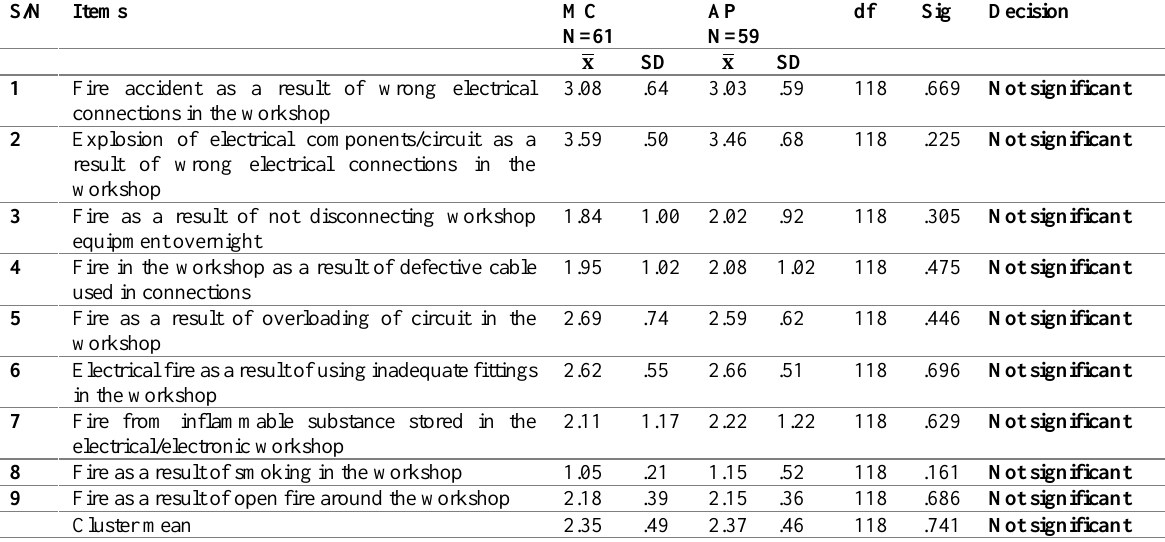
the Electrical/Electronics Workshop.